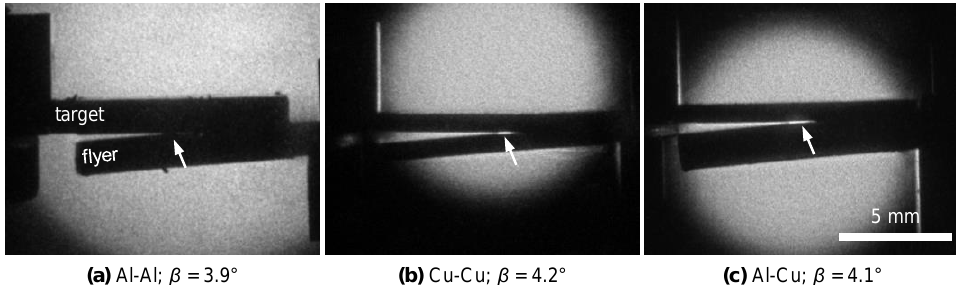
Figure 7. High-speed imaging series of the collision with different material parings at a similar progression point of the collision: Al–Al ( a ); Cu–Cu ( b ); Al–Cu ( c ). All experiments were driven at v imp = 262ms − 1 and closely above the lower collision angle boundary of Cu–Cu and Al–Cu. The exposure time was 20ns for all experiments. The arrows indicate the